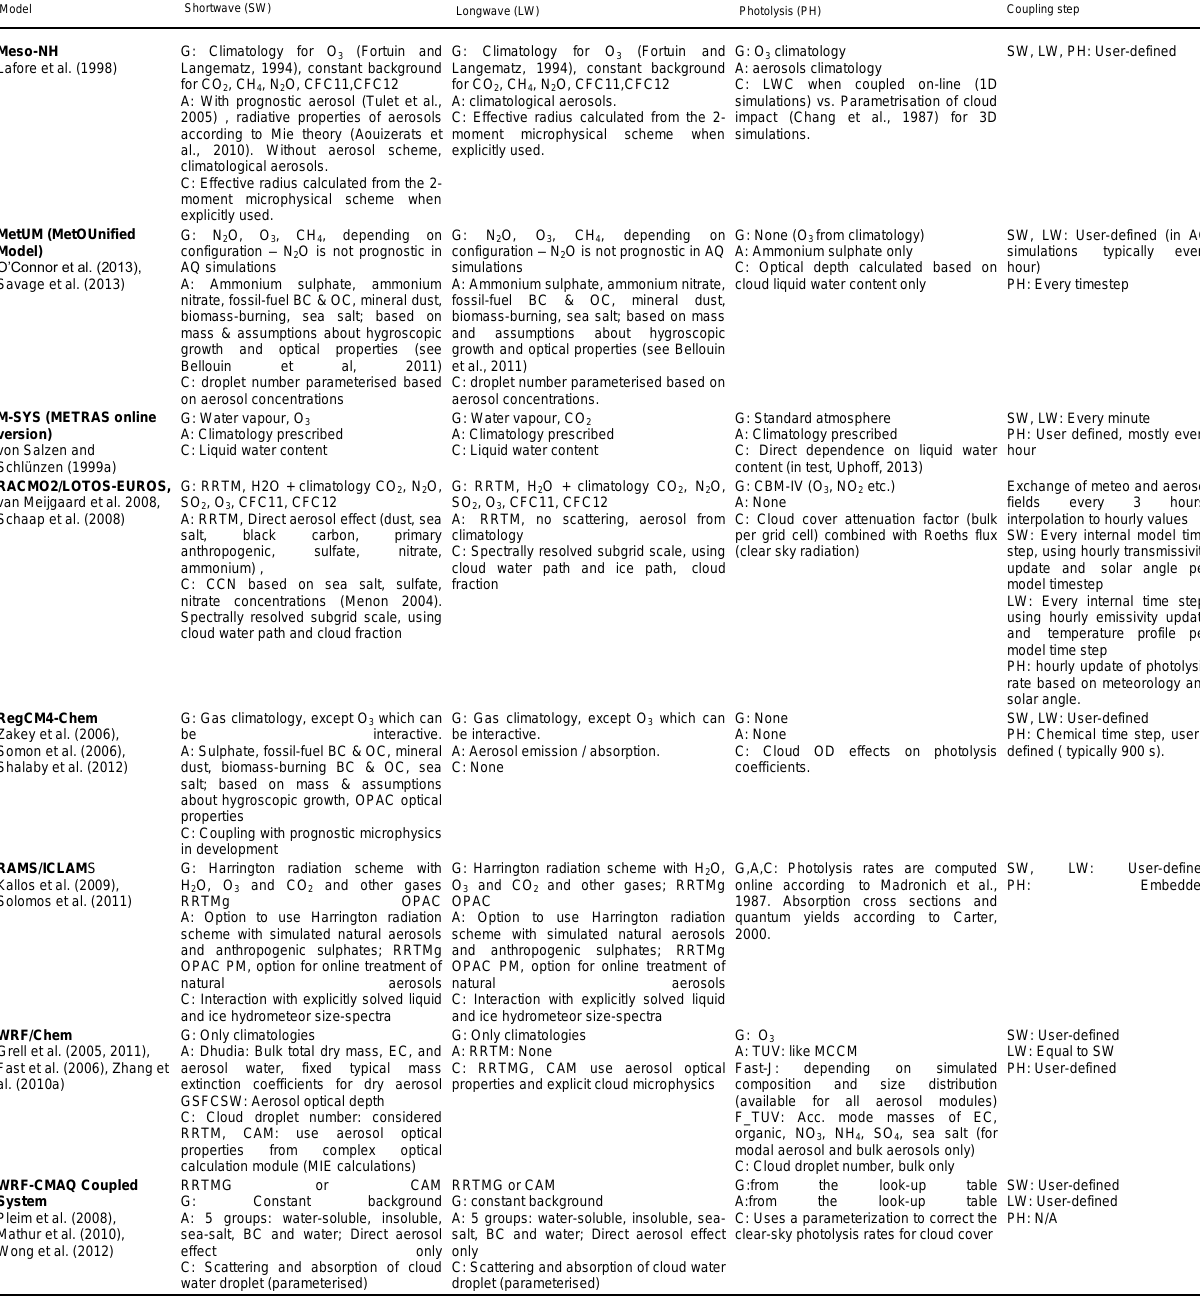
A:from the look-up table C: Uses a parameterization to correct the clear-sky photolysis rates for cloud cover